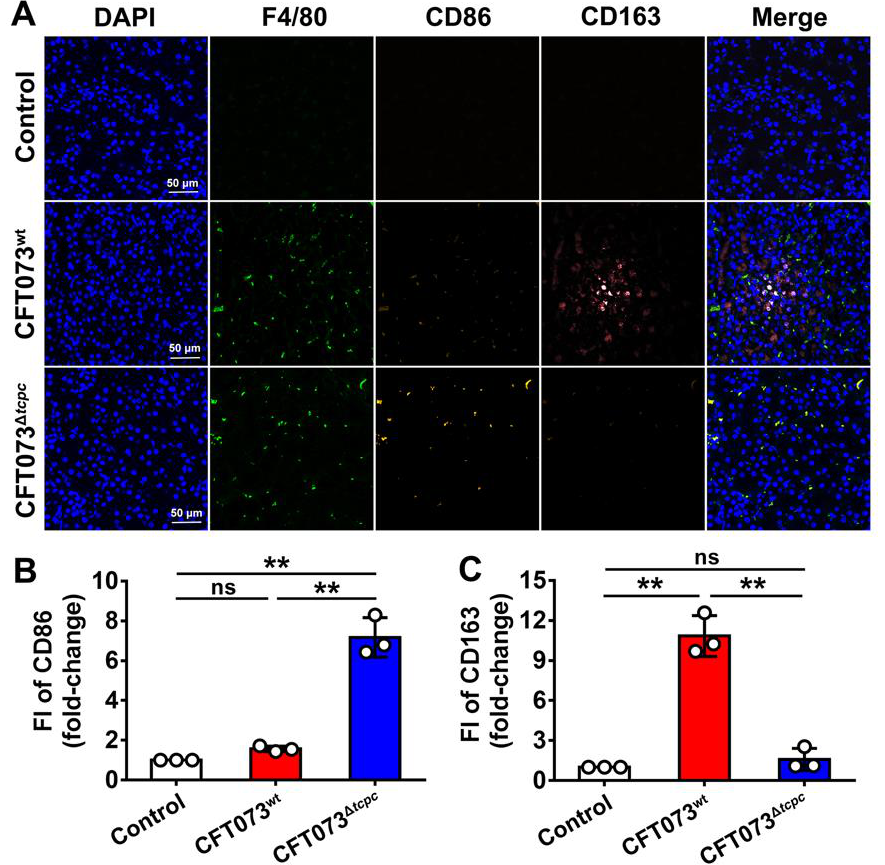
Figure 1. CFT073 wt infection inhibits CD86 but promotes CD163 in situ expression on macrophages in kidneys from PN mouse model. ( A ) The in situ expression of CD86 and CD163 on the surface of macrophages in kidneys from mouse PN model was observed by fluorescence microscope. Scale bar = 50 µ m. One representative image of kidneys from 3 mice in each group was shown. ( B ) The fluorescence intensity (FI) analysis of CD86 in experiments shown in A. ( C ) FI of CD163 levels in experiments shown in A. Mean ± SD of data from three kidneys in each group are shown, n = 3. FI in the control group was set as 1.0. ** : p < 0.01. ns: not significant.